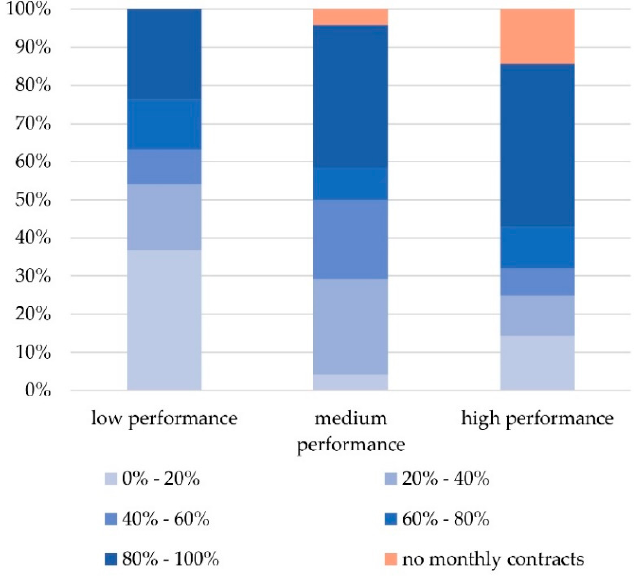
Figure 8. Shares of profitability associated with monthly contracts by performance category (last six months).